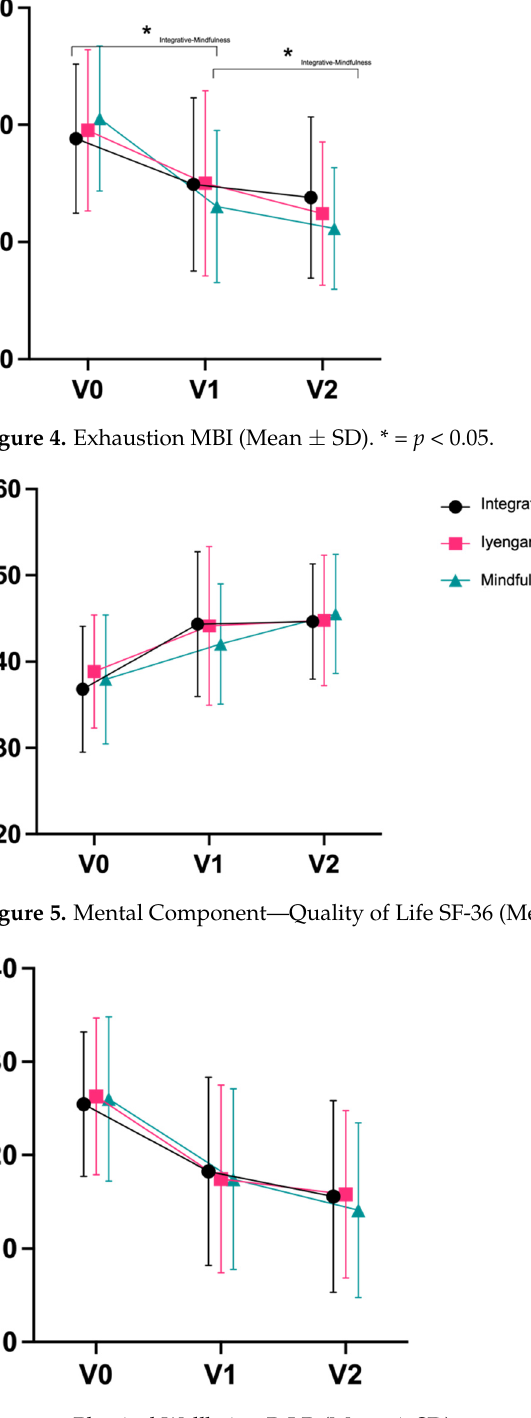
Figure 7. Mindfulness FMI (Mean ± SD).